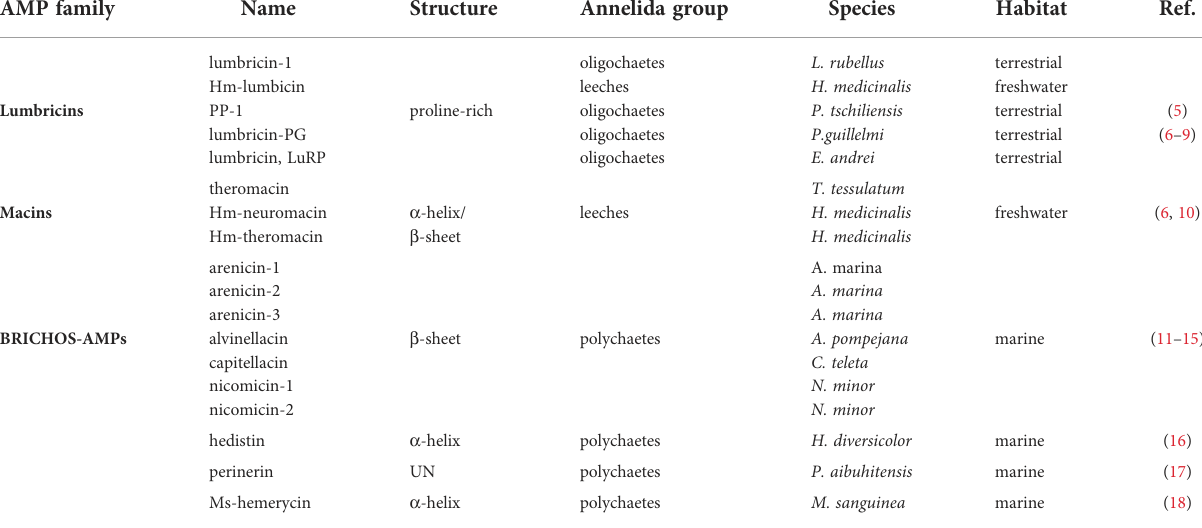
TABLE 1 Antimicrobial peptides in annelids. AMP